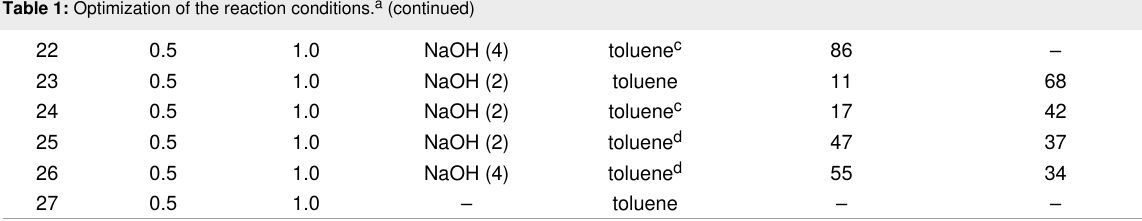
Table 1: Optimization of the reaction conditions. a